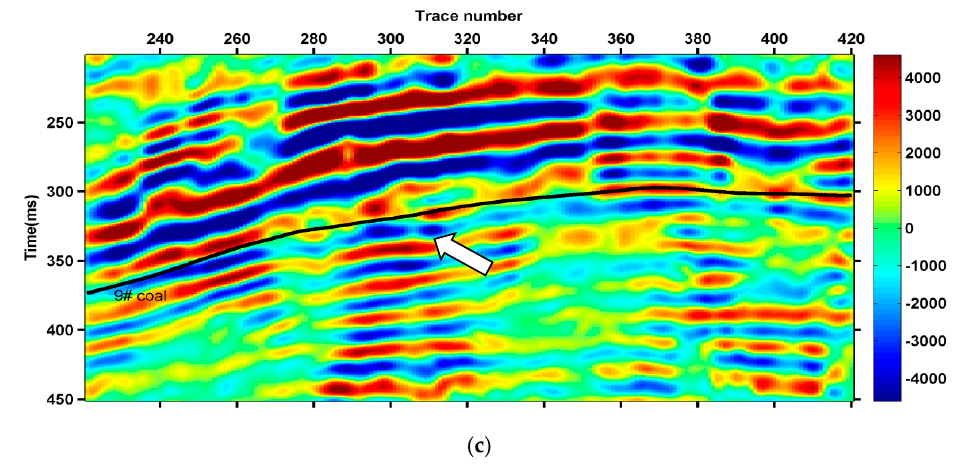
Figure 11. Results of CEEMD: ( a ) IMF1of original seismic data; ( b ) IMF2 of original seismic data; ( c ) IMF3 of original seismic data.